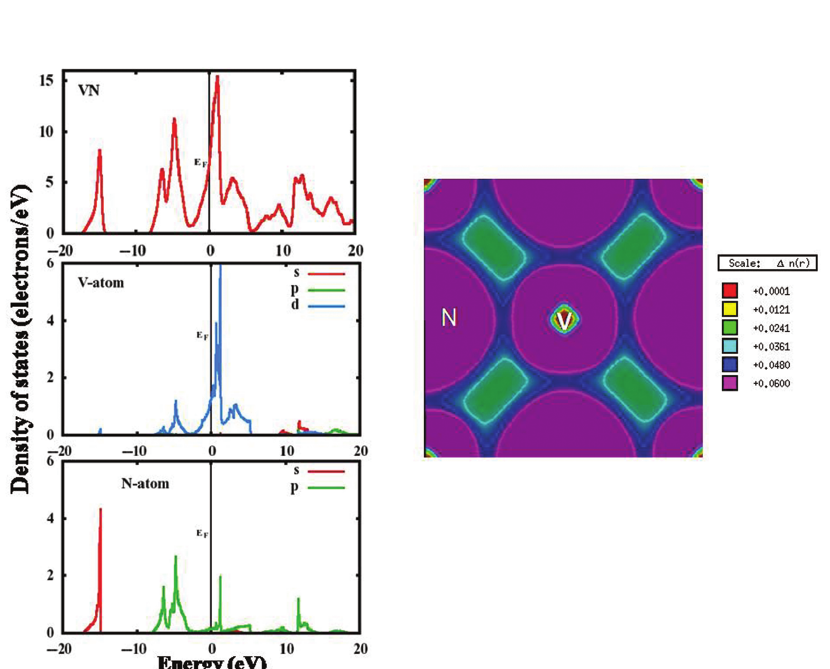
Figure 5: Electronic DOS and 2D charge density of HfN.